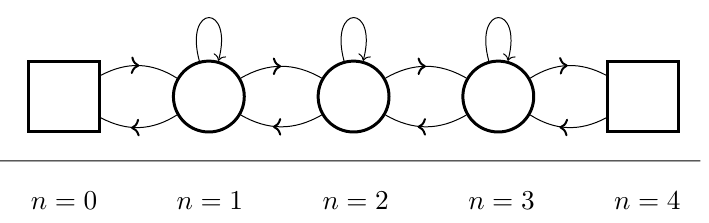
Figure 1. Linear quiver for Class S theories (with ‘ − 2 = 4 and arbitrary N ). The index n = 1 , . . . , ‘ − 3 labels the different gauge nodes of the